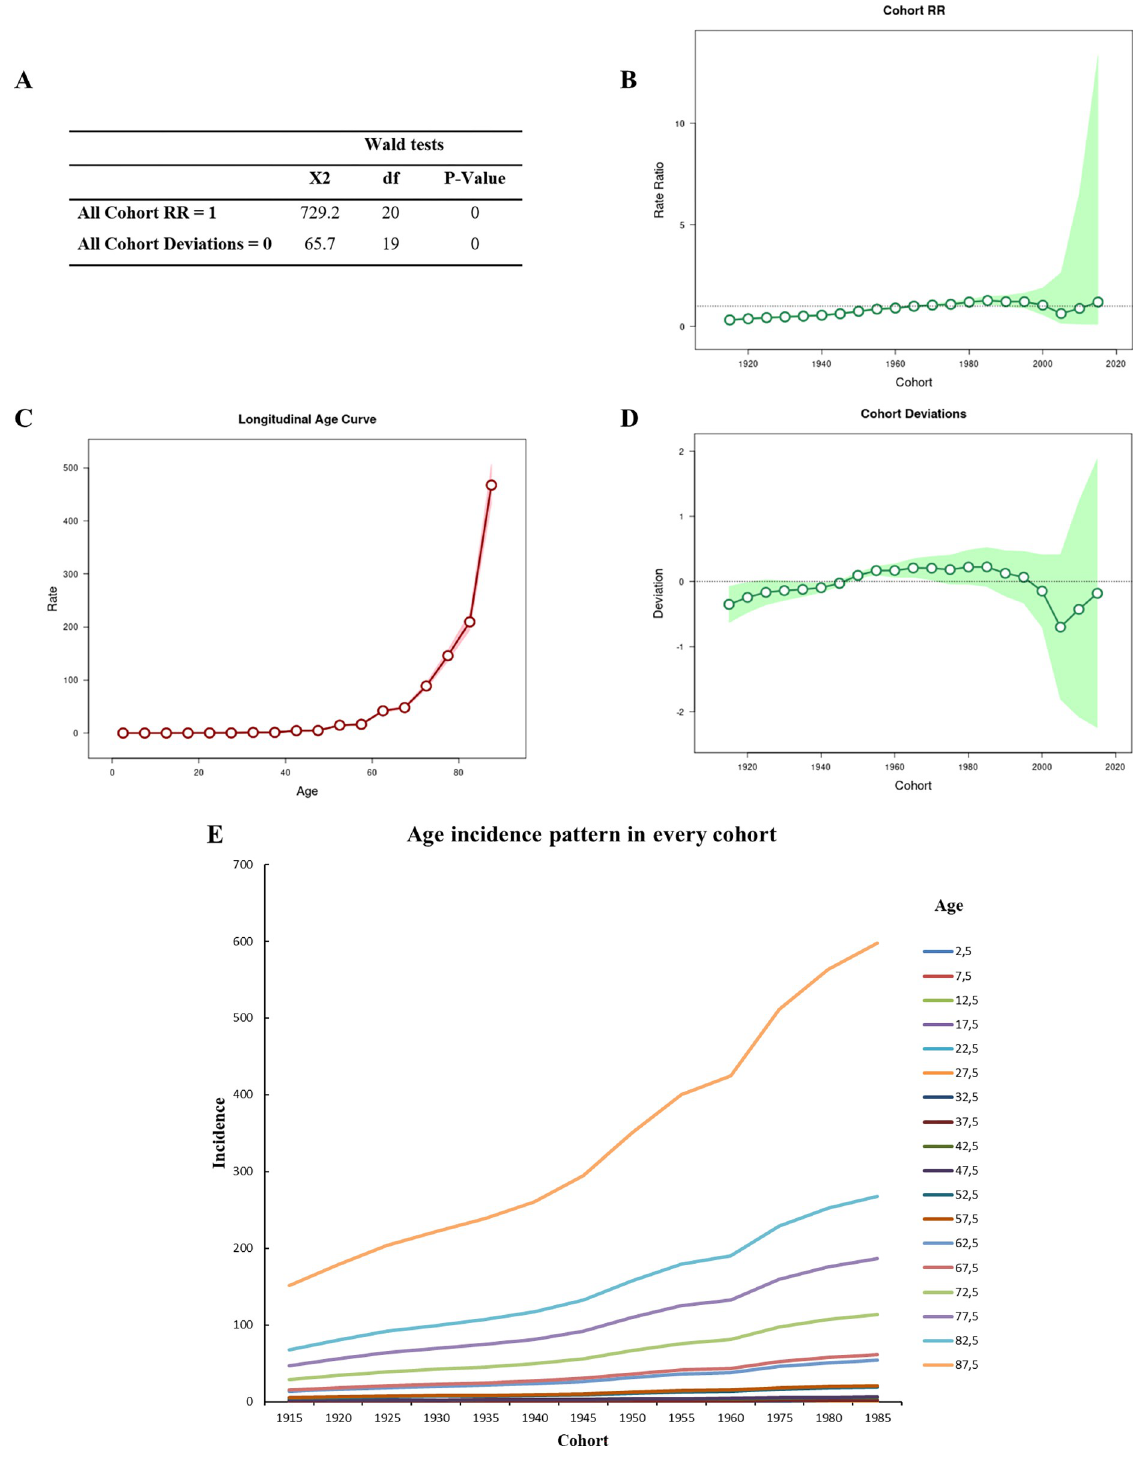
Fig 3. Age-period-cohort analysis using the Wald test (A), with the cohort RR analysis (B), the longitudinal age curve (C), cohort deviations (D), and age incidence patterns for every cohort (E). In Fig 3B-3D, the lines represent the oscillation of the Y-axis value in relation to the X- axis; the circle represents the moment on the X-axis; the shadows above the lines represent the 95% CIs.